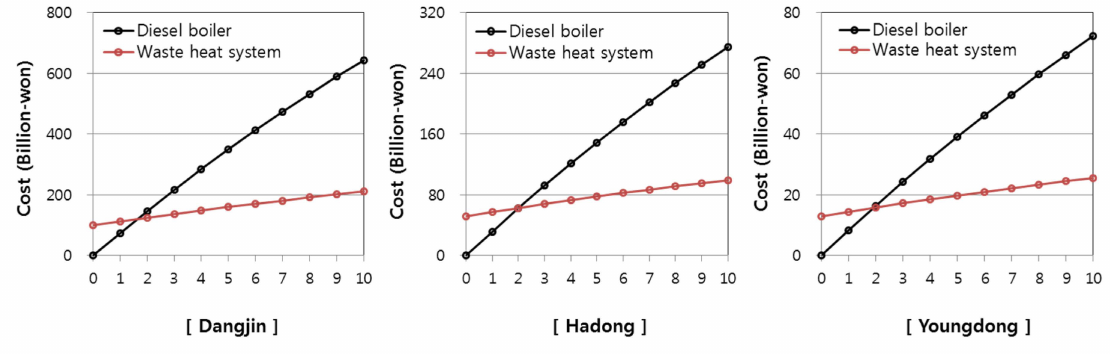
Figure 11. LCC comparative and payback period